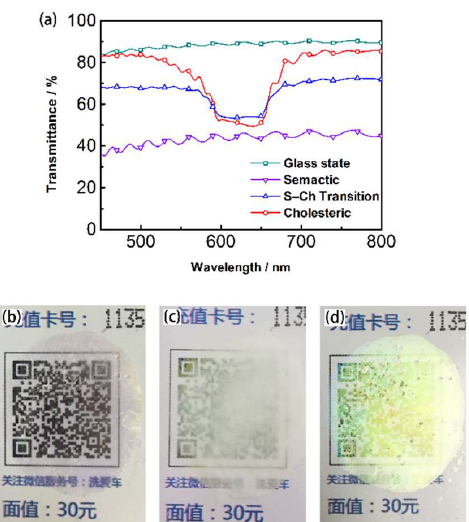
Figure 4. ( a ) The transmission spectra of the samples at different temperatures. Pictures of the liquid crystal (LC) film during the finger heating process: ( b ) transparent state, ( c ) scattering state, ( d ) both reflection and scattering states, and ( e ) reflection state.